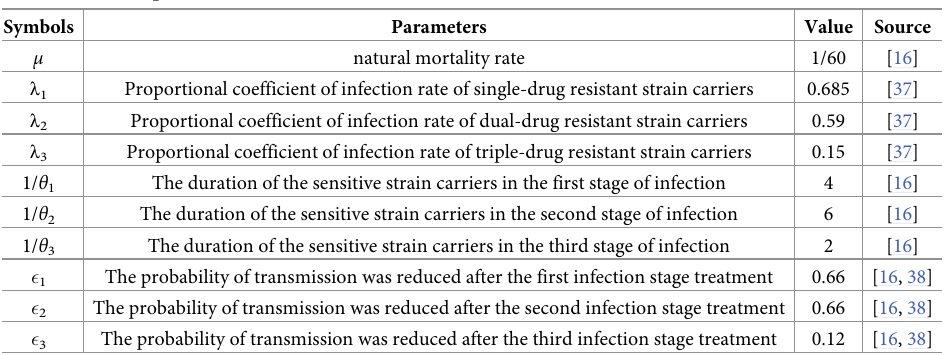
Table 3. Constant parameters.